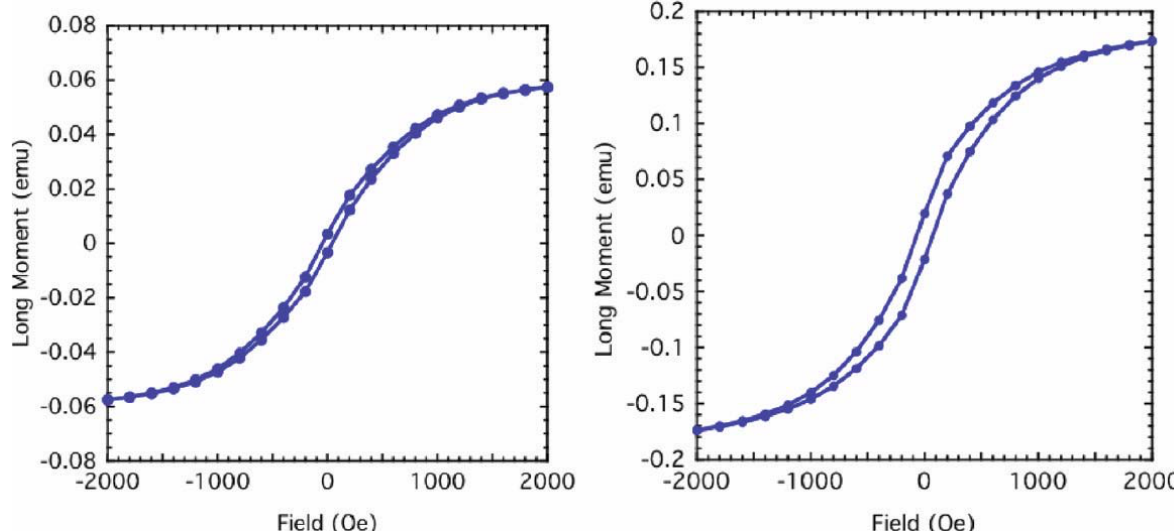
Figure 10. The magnetization of the Fe silicon-doped bcc-Fe nanoparticle-containing product (right) as a function of the magnetic field; the hysteresis loop being depicted. Reproduced from Ref. [8] with permission from American Chemical